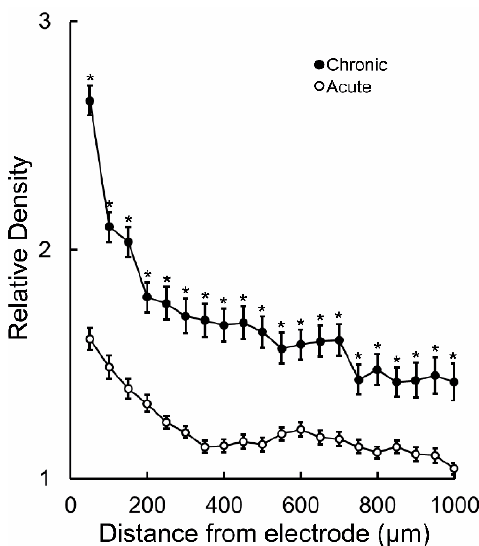
Figure 3. Normalized GFAP-immunostaining density (mean ± SEM) within 1000 µm from the microelectrode track in chronically- and acutely-implanted marmosets. Asterisks indicate statistically significant difference between acute vs. chronic regions of the same distance from microelectrodes implants p < 0.05.